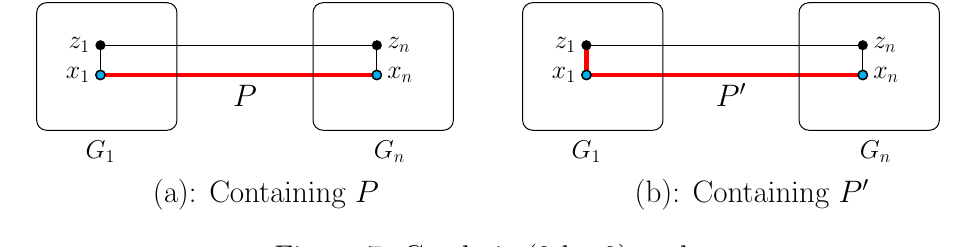
Figure 7: Geodesic (2 d +